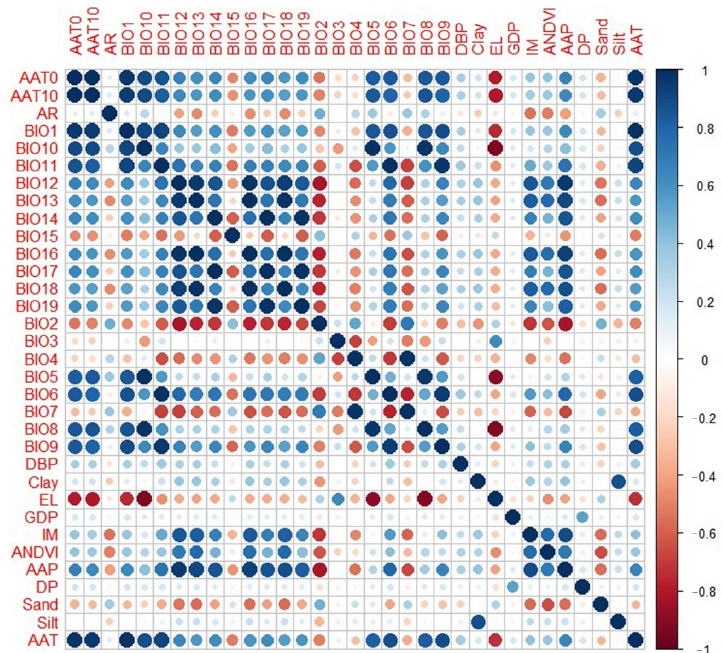
Figure 2. Diagnostics correlations with environmental factors.